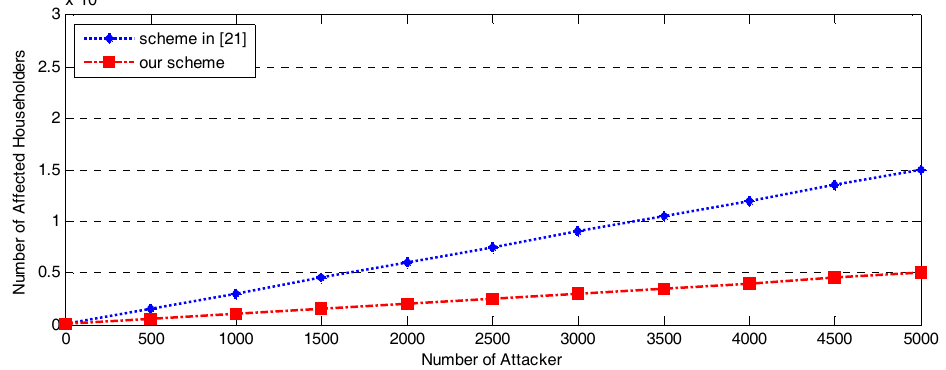
Figure 9. Affected householders in our scheme and the scheme in [21] with different numbers of attackers.